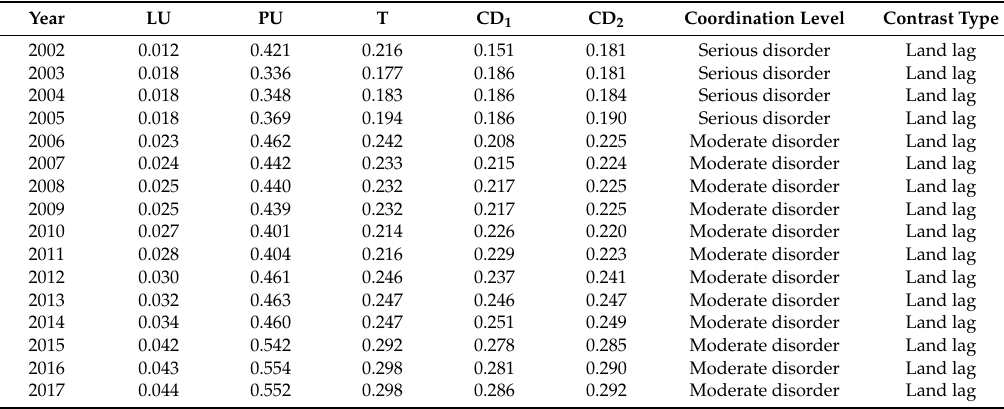
Table 4. The dynamic relationship of urbanization from 2002 to